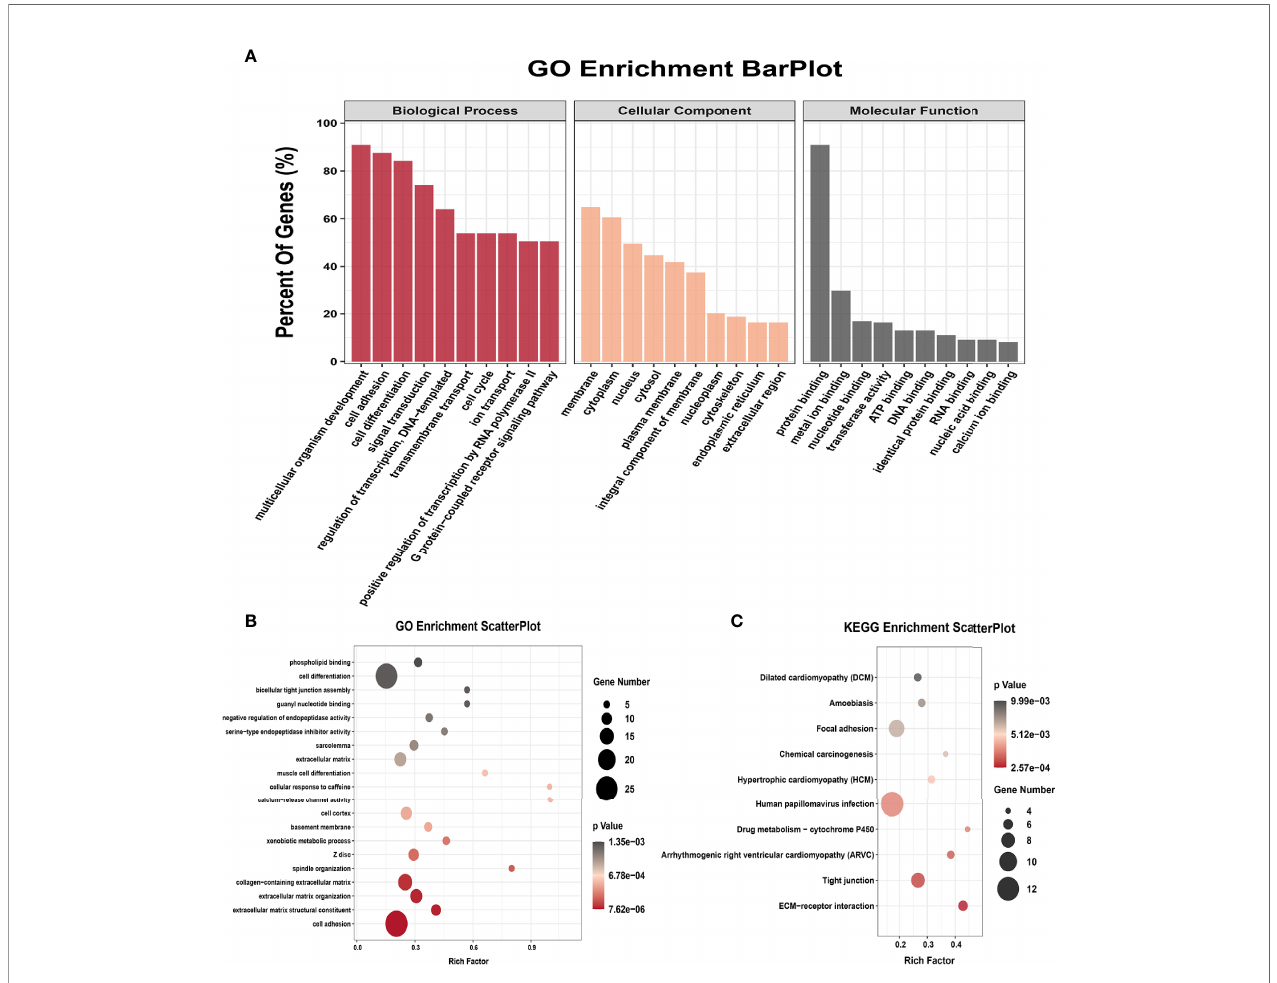
FIGURE 4 | GO terms and KEGG pathways of genes with signi fi cant alterations in both the m6A modi fi cation and mRNA levels. (A) Major enrichment and meaningful GO terms of genes with signi fi cant alterations in both the m6A modi fi cation and mRNA levels. (B) The top 20 GO terms of genes with signi fi cant alterations in both the m6A modi fi cation and mRNA levels. (C) The top 10 KEGG pathways of genes with signi fi cant alterations in both the m6A modi fi cation and mRNA